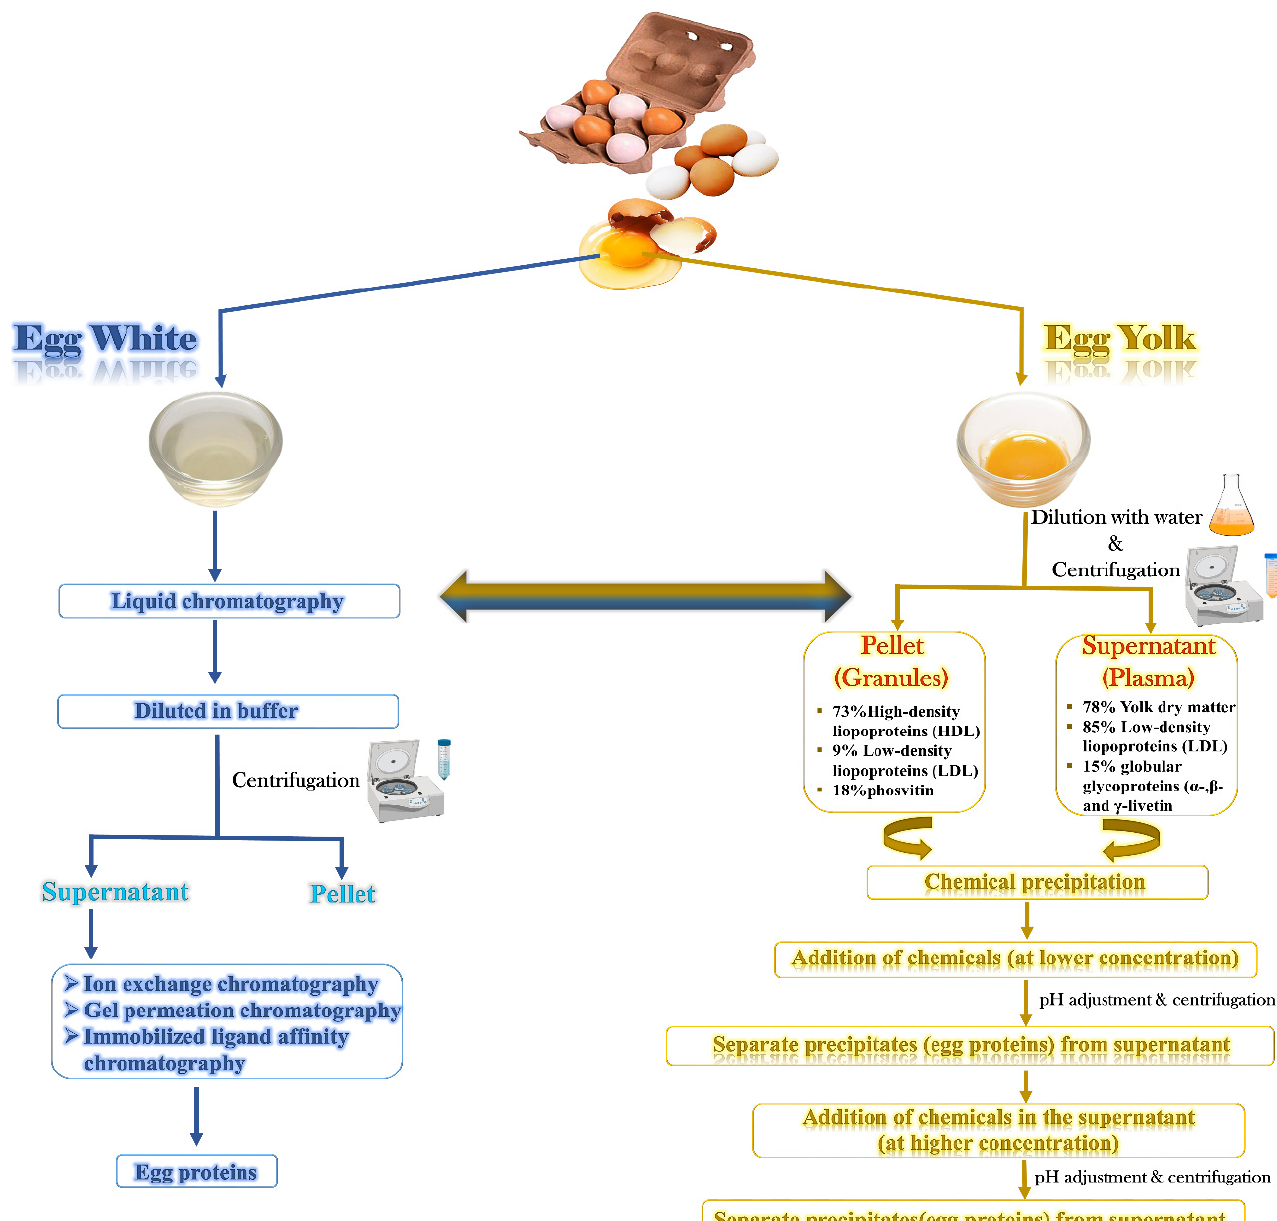
Figure 1. The process of separating egg proteins into fractions using liquid chromatography and chemical precipitation is visually represented.